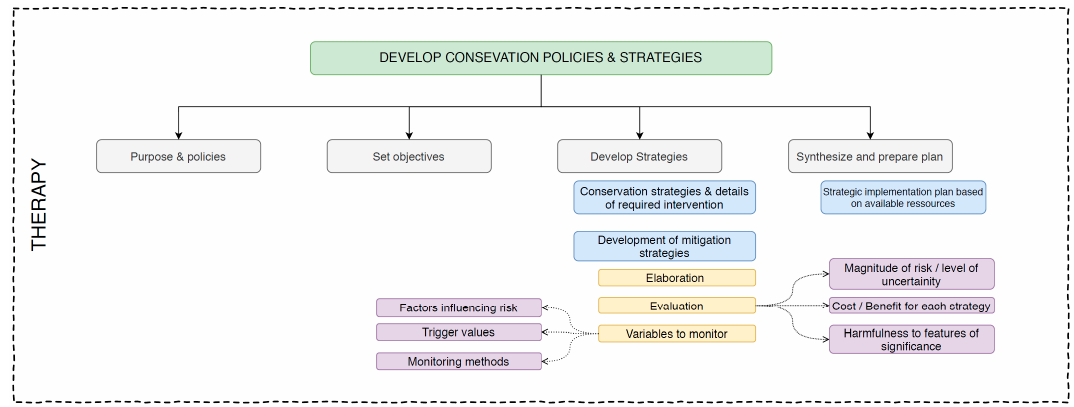
Figure 3. Therapy: the third phase of the management plan process.